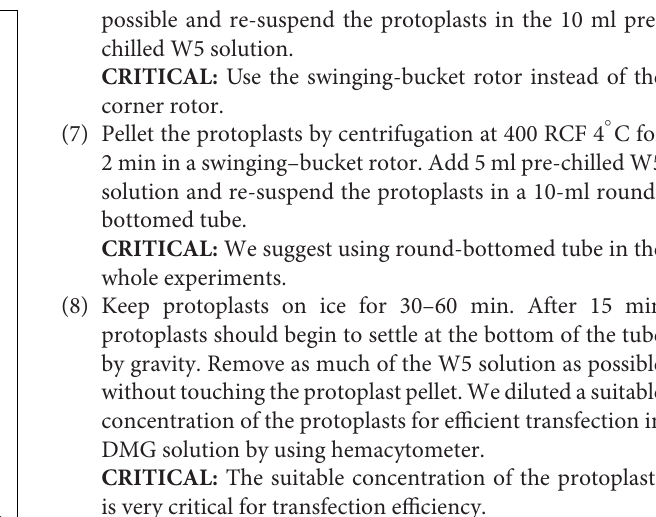
Frontiers in Plant Science |